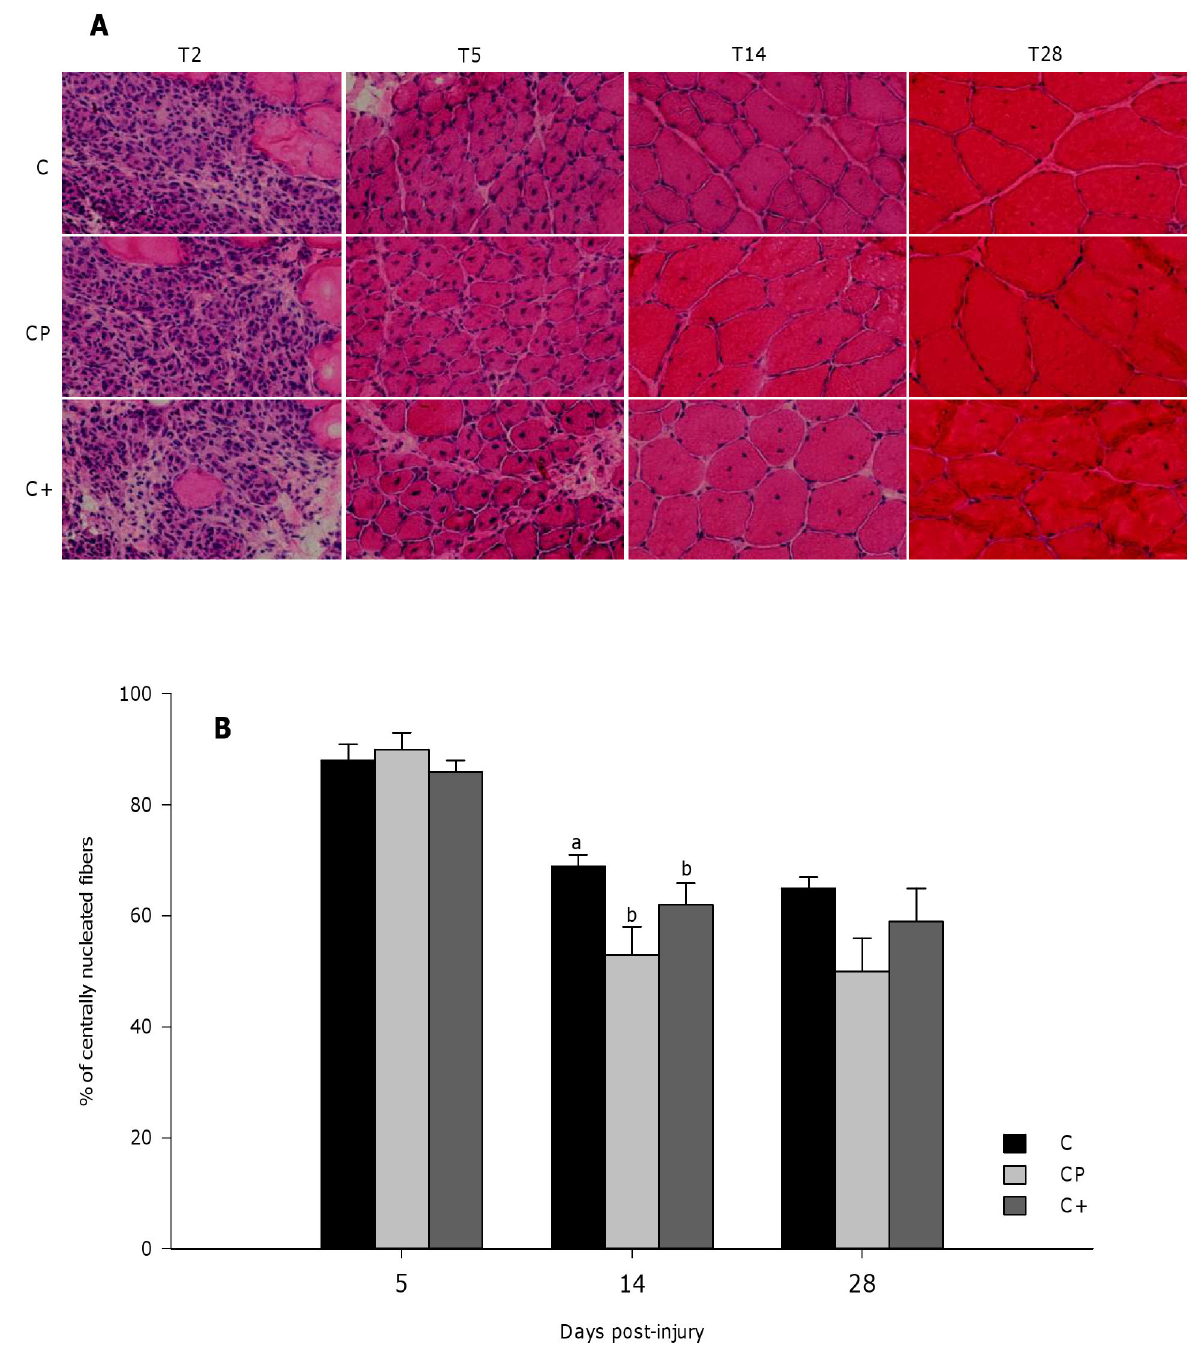
Figure 1. Representative H/E stained cross-sections and percentage of centrally nucleated myofibers. The number of centrally nucleated myofibers was counted in two non crossing H/E-stained sections of injured muscles collected at days 5, 14, and 28 post-injury. Representative H/E stained cross-sections and the percentages of centrally nucleated myofibers are shown in panels A and B, respectively. Data from panel B are expressed as a percentage of the total myofibers in the cross-sections. Values are mean ± SEM (n = 7-8 rats per dietary group/time point). Groups bearing different letters for a given time point are significantly different (p≤0.05). C, casein; CP, cod protein; C + , casein supplemented with L-arginine, glycine, L-taurine and L-lysine.